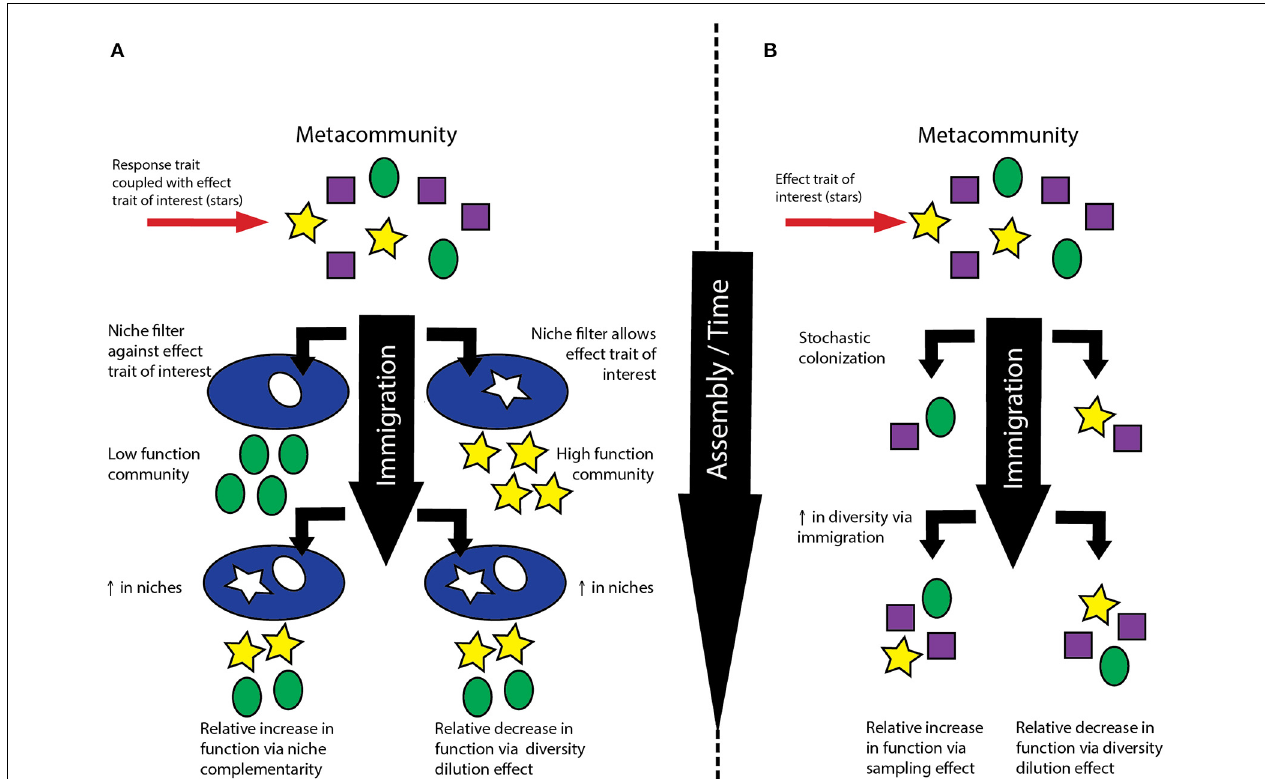
FIGURE 1 | (A) Relationship between niche-driven increases in biodiversity and ecosystem function. Shapes represent traits where response and effect traits are directly coupled; the trait of interest is represented as a yellow star. Depending on the initial community, increases in diversity can lead to increases in relative function through niche complementarity or decreases through the biodiversity dilution effect. (B) Relationship between stochastic, neutrally-driven increases in biodiversity and ecosystem function. The trait of